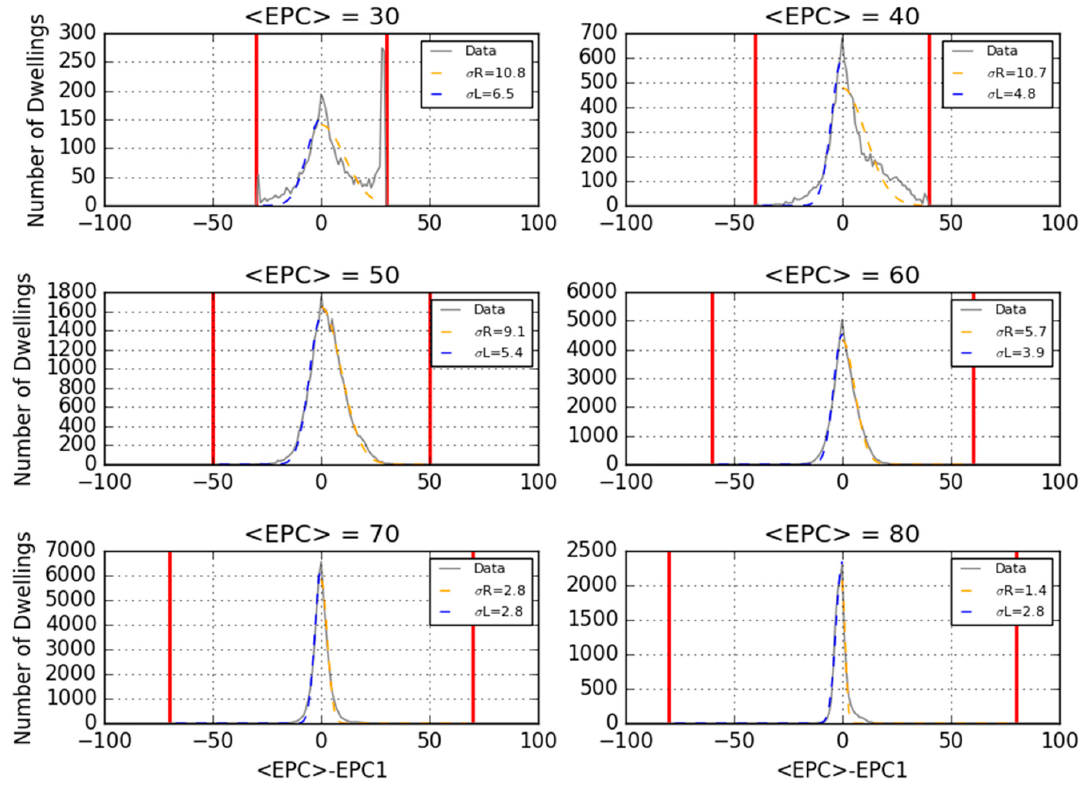
Figure 8. Distribution of <EPC>-EPC1 for certain values of <EPC>. Data fitted with a different half- Gaussian distribution to the left of zero ( σ L ) and right of zero ( σ R ).